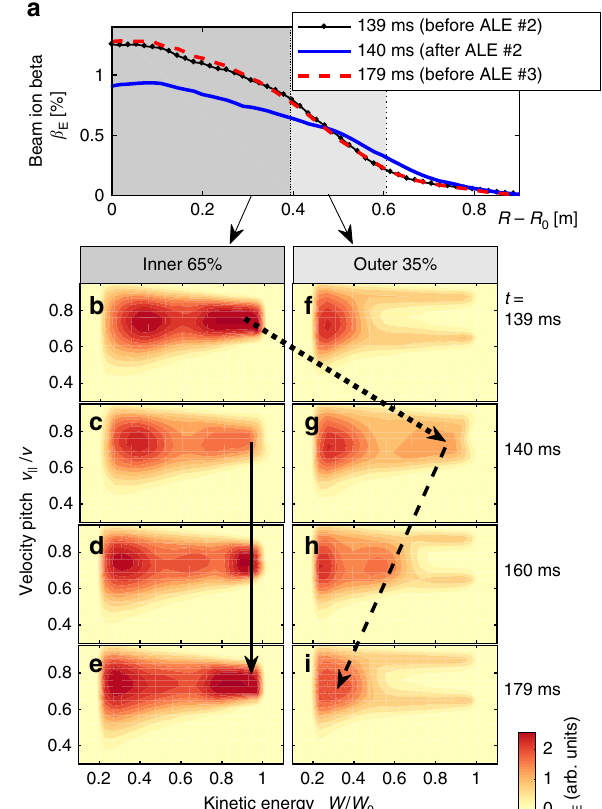
Fig. 4 Evolution of the beam ion distribution. For the time interval between the second and third ALE in the B 0 = 1.20T case, panel a shows the evolution of the energetic ion beta pro fi le β E ( R − R 0 ) measured in the midplane (at Z 0 = 0.2 m), where R − R 0 is the radial distance from the plasma centre (at R 0 = 3.4 m) towards the outboard side of the tokamak. Note that the energetic ion orbits extend beyond the plasma boundary (located at R − R 0 = 0.6 m) into the surrounding vacuum (white area). The pro fi les in a were smoothed by averaging over 10 radial grid points, which are indicated as dots on the fi rst pro fi le (black). Panels b – e show the ð W ; v = v Þ in the core (inner 65% of evolution of the velocity distribution F jj E the plasma), and panels f – i in the periphery (outer 35%). The kinetic energy W = M D v 2 /2 of the deuterons is normalised by their birth energy W v = v , where v jj jj is the 0 . The velocity pitch is measured by the ratio velocity component along the magnetic fi eld. The dotted arrow from b to g indicates the abrupt migration of energetic particles from the core plasma into the periphery during the interval 139 ms ≤ t ≤ 140 ms (ALE #2). The solid arrow from c to e indicates how the beams replenish the energetic ion population in the core until t = 179 ms (before ALE #3). Meanwhile, the number of energetic ions in the periphery decreases, because the migrated particles slow down via collisional drag as indicated by the dashed arrow from g to